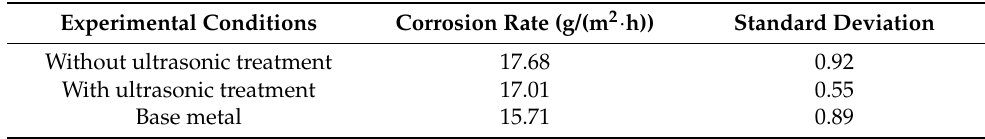
Table 4. Results of the immersion pitting-corrosion testing for all